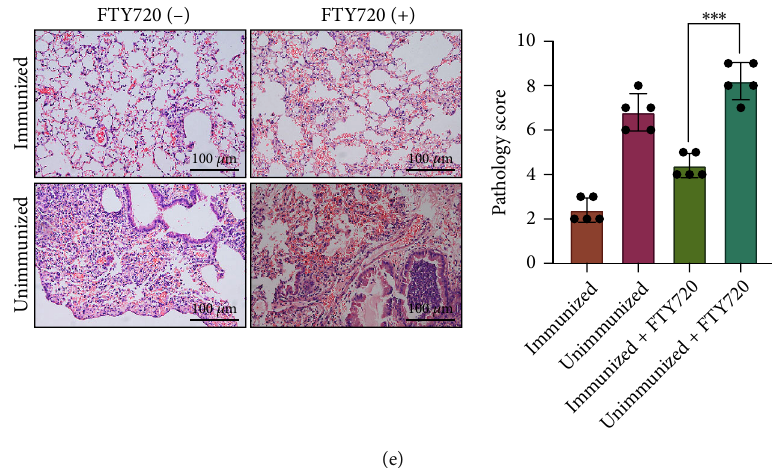
Figure 4: CD4 + T cells protect against Pseudomonas aeruginosa pulmonary infection. (a) The survival of naïve C57BL/6 mice with or RM without FTY720 treatment and rePcrV-immunized mice with or without FTY720 treatment ( n = 10 ). ∗∗∗ P < 0 : 01 by log-rank test. (b) Global disease score in 4 groups of mice after challenge with 1 : 3 × 10 6 CFU of P. aeruginosa XN-1 ( n = 10 ). (c) Weight loss in the naïve mice with or without FTY720 treatment and rePcrV-immunized mice with or without FTY720 treatment after challenge with 1 : 3 × 10 6 CFU of P. aeruginosa XN-1 ( n = 10 ). (d) Lung CFU 24 hours after infection in the naïve mice with or without FTY720 treatment and rePcrV-immunized mice with or without FTY720 treatment ( n = 4 ). (e) Representative H and E stains in naïve mice with or without FTY720 treatment and rePcrV-immunized mice with or without FTY720 treatment lung 24 hours post- P. aeruginosa XN-1 challenge are shown ( scalebar = 100 μ m ) ( n = 5 ). Signi fi cant di ff erences are designated by using Student ’ s t -test. ∗ P < 0 : 05 ; ∗∗ P < 0 : 01 ; ∗∗∗ P < 0 : 001 ; ∗∗∗∗ P < 0 : 0001